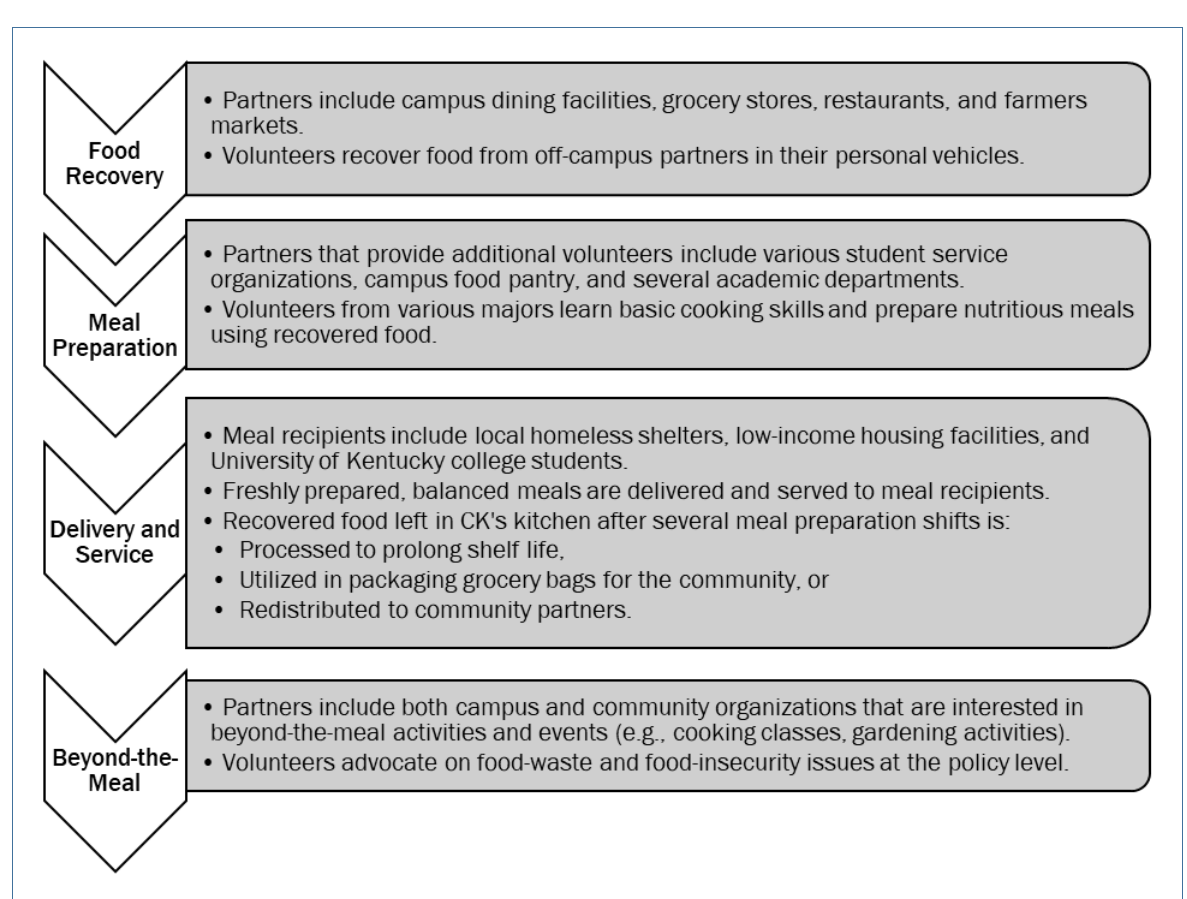
Figure 2. Campus Kitchen at the University of Kentucky (CK) ’s Model, Partners, and Weekly